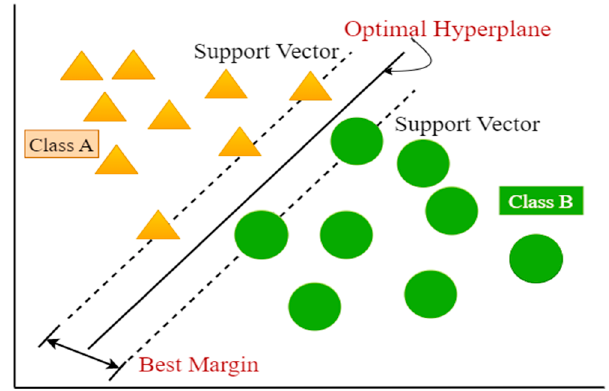
Figure 3. Basic structure of SVM.